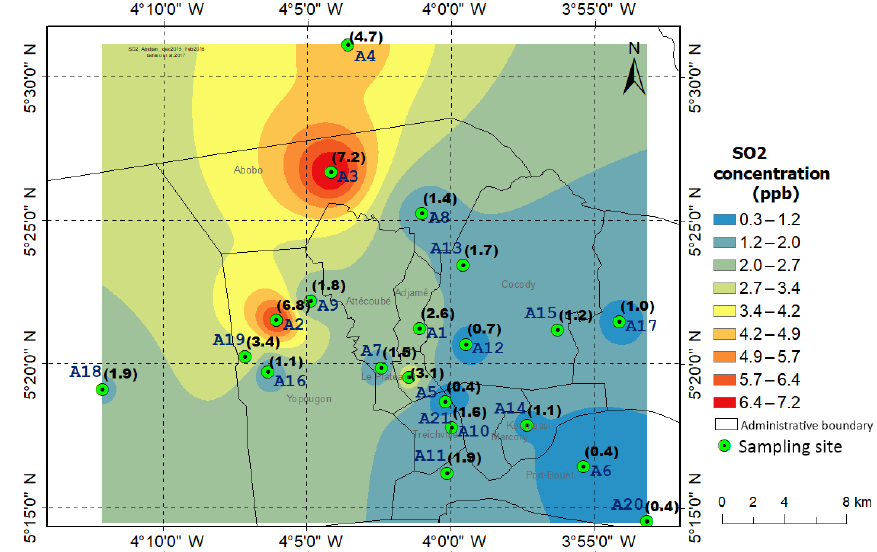
Figure 8. Spatial distribution of SO 2 in the district of Abidjan during the dry season (15 December 2015–16 February 2016). Measured concentrations in ppb are in brackets.